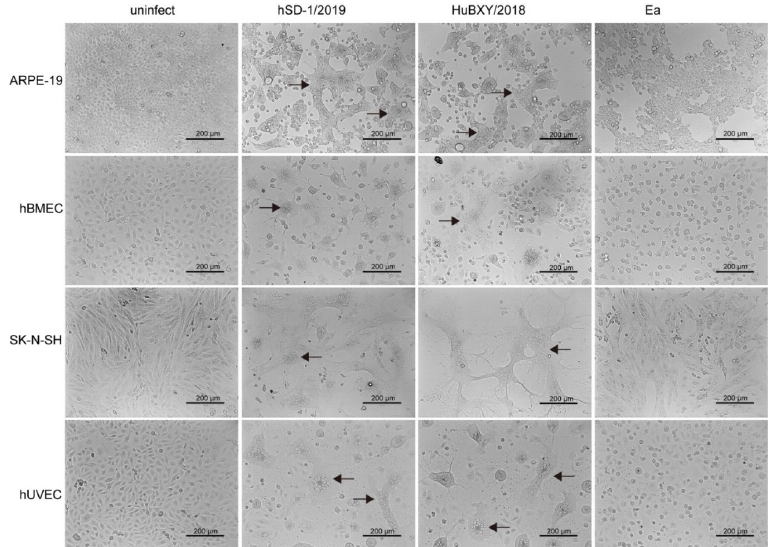
Figure 6. Cytopathic effects of PRV strains in different human cells. In ARPE, hBMEC, SK-N-SH, and hUVEC cells, hSD-1/2019, and HuBXY/2018 induced large syncytia, while the Ea-infected cells showed cytopathic effects characterized by single, rounded, and swollen cells. Syncytia are indicated using black arrows.